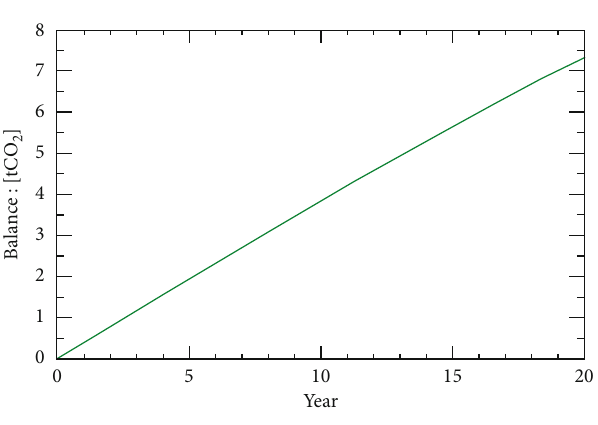
Figure 5: Saved CO ₂ emission vs